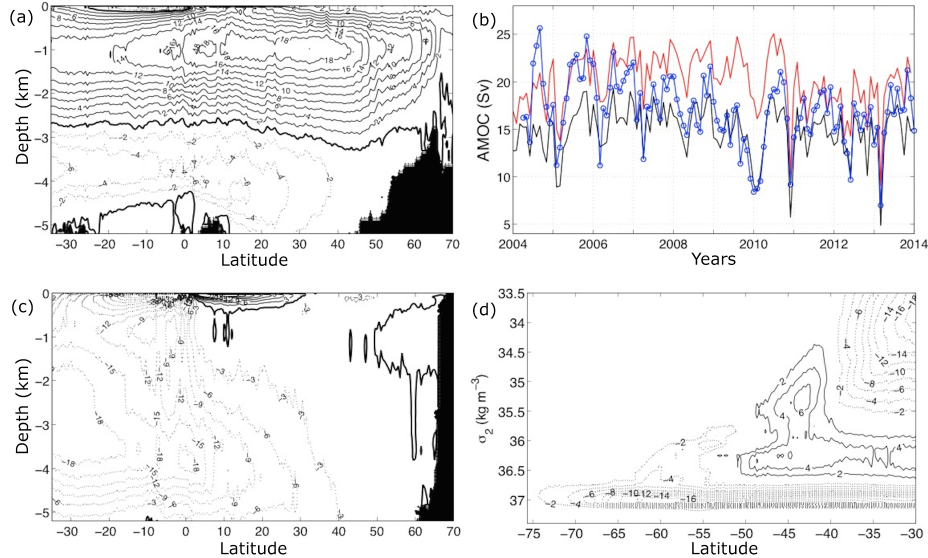
Figure 3. Meridional overturning stream function (in Sv) averaged over the period 2009–2013, calculated in depth space for (a) the Atlantic and (c) the Indo-Pacific basins and in density space as function of σ 2 for (d) the Southern Ocean. The contour interval is 2Sv in panels (a, d) and 3Sv in panel (c) . Thin solid lines represent positive (clockwise) contours; thick solid lines represent zero contours. The stream functions were calculated with 0.5 ◦ latitudinal spacing to smooth out small-scale variations. (b) Time series of the AMOC at 26.5 ◦ N from RAPID observational estimates (blue), GLOB16 (red), and GLOB4 (black) numerical simulations.